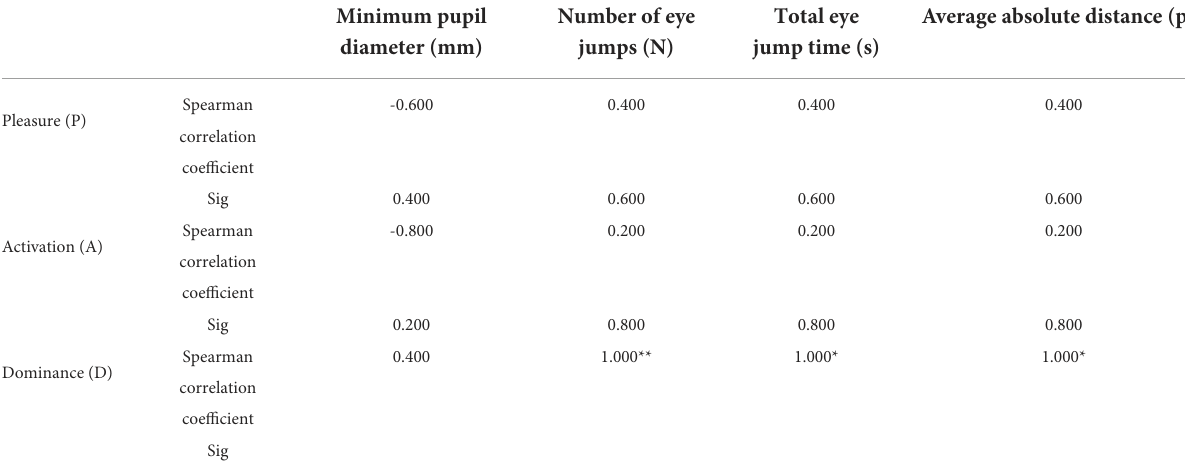
TABLE 5 Eye movement index and PAD value Spearman correlation test.